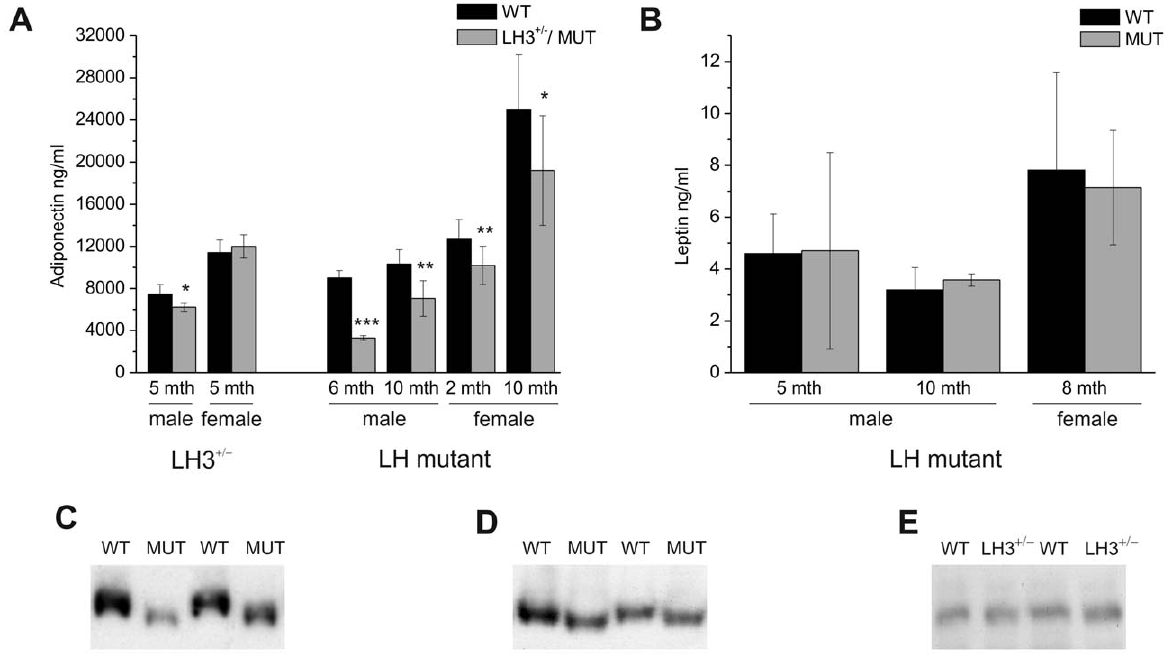
Figure 3. Total adiponectin levels in LH mutant mice and heterozygous LH3 knockout mice. (A) Total adiponectin levels were significantly reduced in the serum of LH mutant mice (MUT), but not in the heterozygous LH3 knockout (LH3 + / 2 ) mice. Adiponectin level analyses were done from the serum of the 5 months old male (n=6 wt, 5 ko + / 2 ) and female (n=6 wt, 6 ko + / 2 ) LH3 + / 2 mice, and 6 months (n=6 wt, 5 mut) and 10 months (n=7 wt, 5 mut) old male, and 2 months (n=7 wt, 5 mut) and 10 months (n=9 wt, 7 mut) old female LH mutant mice with ELISA. (B) Total leptin levels were comparable in LH mutant and wild type mice. Leptin analyses were done from the serum of the 5 months (n=6 wt, 4 mut) and 10 months (n=4 wt, 3 mut) old male, and 8 months (n=5 wt, 5 mut) old female LH mutant mice with ELISA. (C) Adiponectin monomers from LH mutant and wild type serum exhibited differences in electrophoretic mobility. In order to evaluate the electrophoretic mobility of adiponectin, different volumes, 5 m l and 10 m l, of diluted (1/300) serum of wild type and LH mutant mice were separated near the end of a 15% SDS-PAGE. (D) The immunoblot analysis of adipose tissue homogenate (41 m g of protein) of wild type and LH mutant male mice did not show differences in the levels of adiponectin monomers, but the electrophoretic mobility of LH mutant adiponectin was clearly increased compared to that of the wild type. (E) In the adipose tissue of LH3 + / 2 mice (50 m g of protein loaded on the gel) no shift in the mobility or in the amount of adiponectin monomers was detected. In immunoblots C, D and E two representative wild type, LH mutant and LH3 + / 2 samples are shown. The values represent the average 6 SD of the experiments. P values were calculated using unpaired homoscedastic student t-test with two-tailed distribution. * p , 0.05, ** p , 0.01, *** p , 0.001.